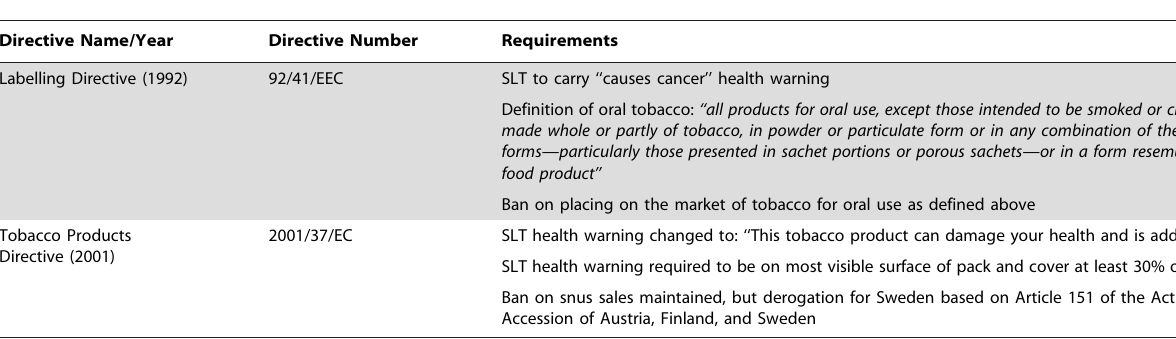
Table 2. EU Tobacco Control Directives specifically addressing SLT.